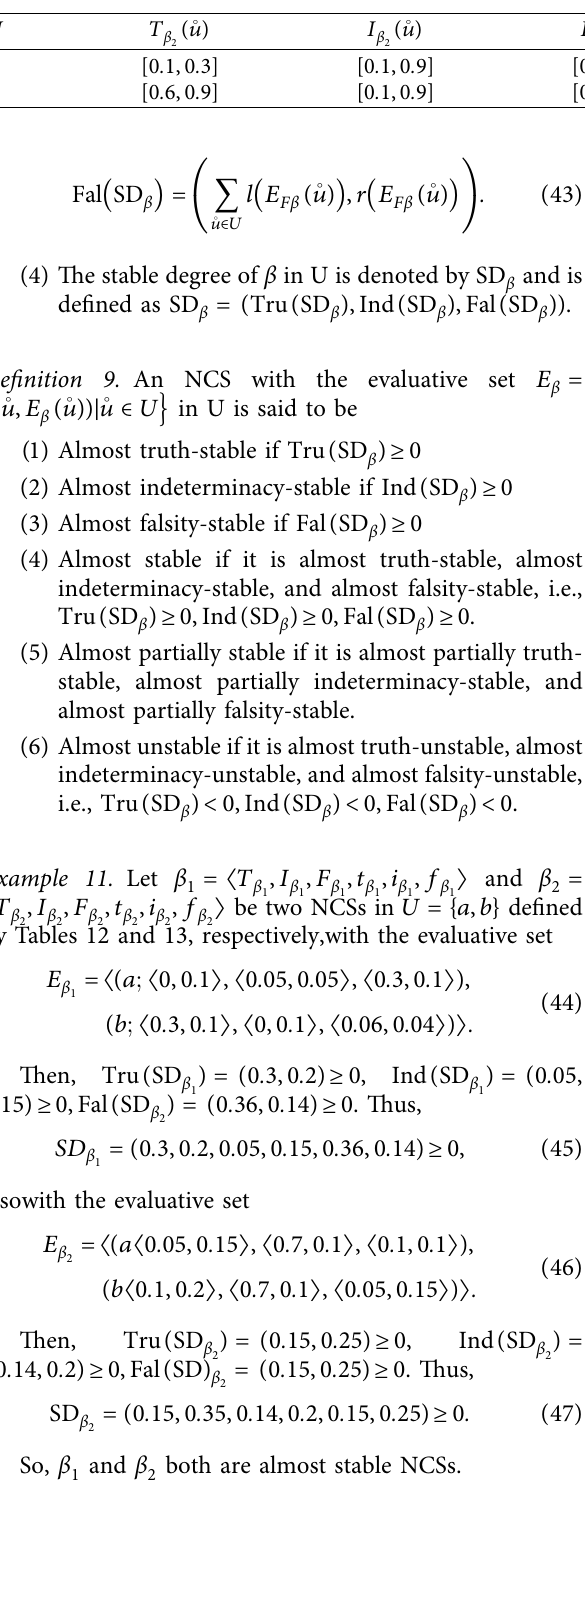
Table 11: Neutrosophic cubic set β